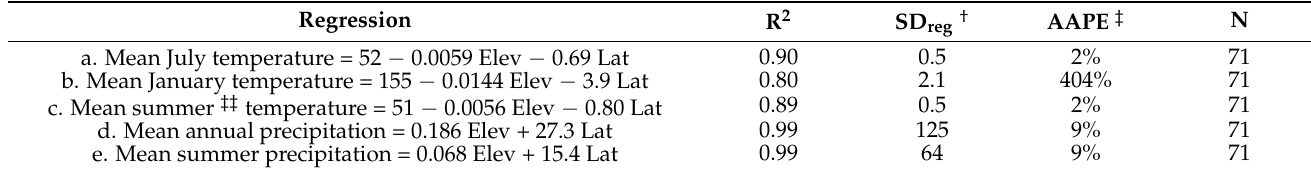
Table 7. Effect of elevation in meters (Elev) and latitude (Lat) on climatic variables in West Virginia (temperature, ◦ C; precipitation, mm).